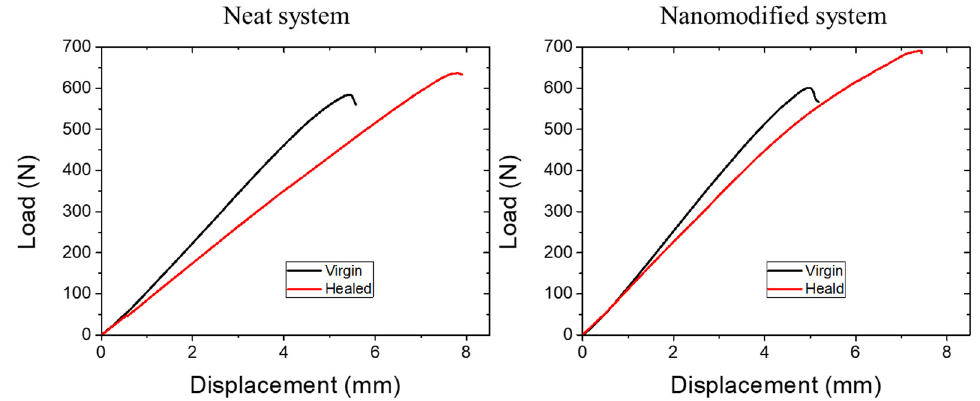
Figure 5. Representative plots of reference (black), neat (red line) and nanomodified (blue line) sys- tems of mode-II specimens.